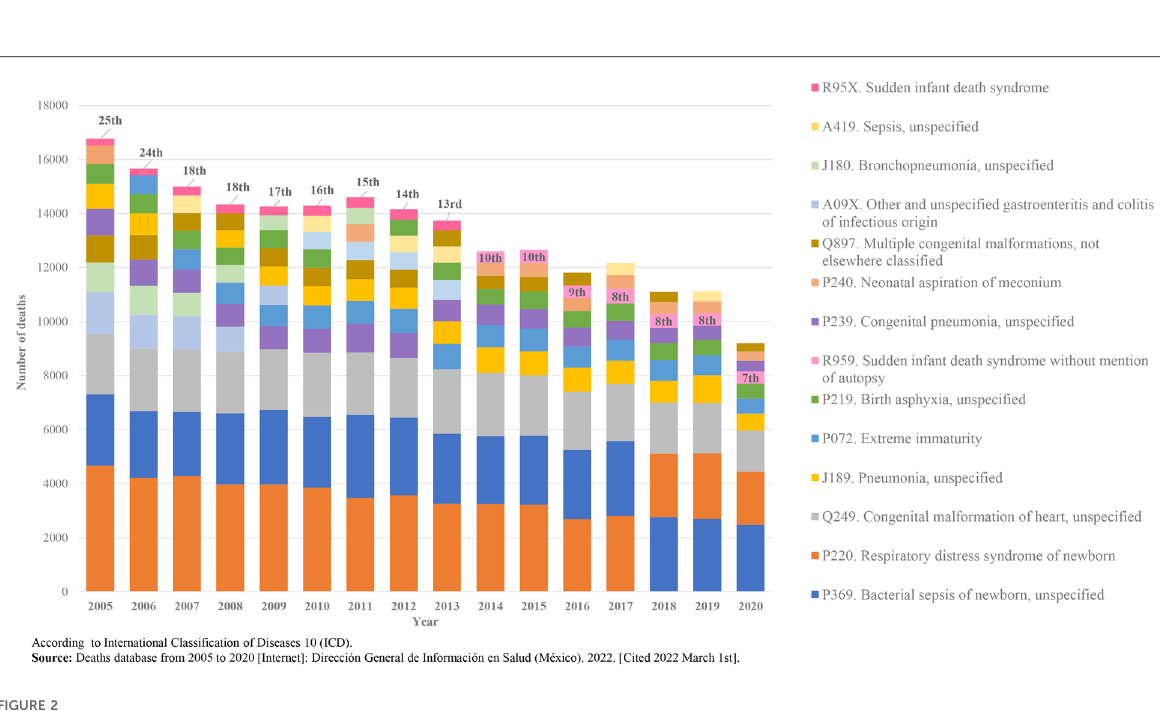
FIGURE 2 SIDS ’ position as leading cause of death in children under one year of age, 2005 – 2020. Mexico. [Graph].